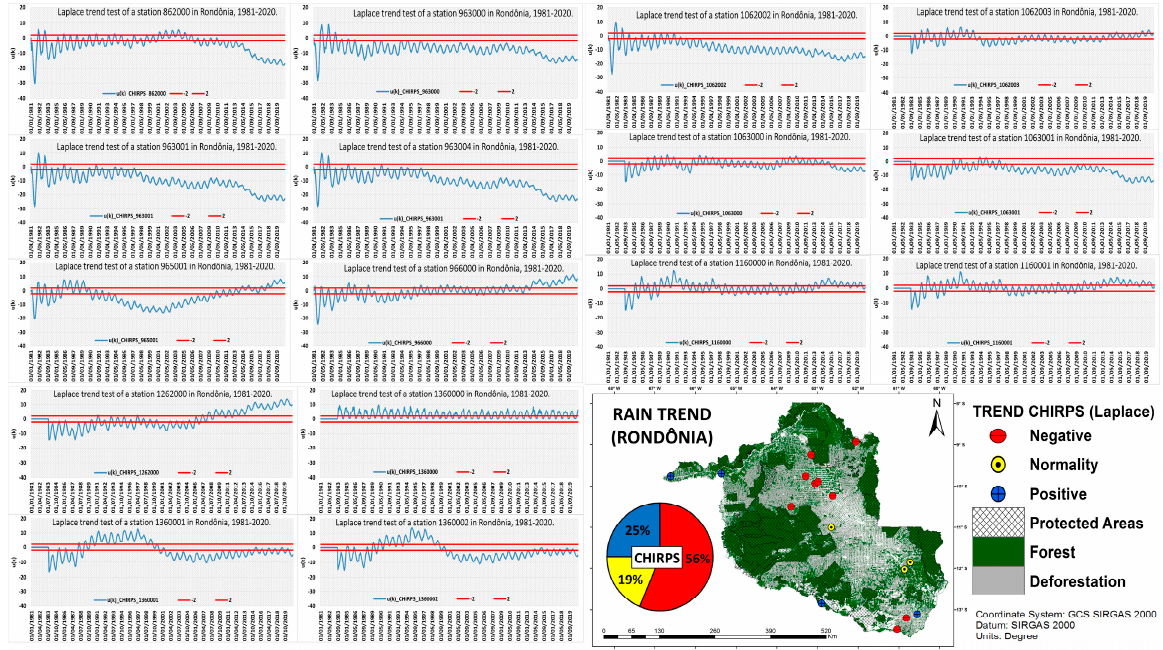
Figure 14. Laplace trend test spatialization for the State of Rondônia.